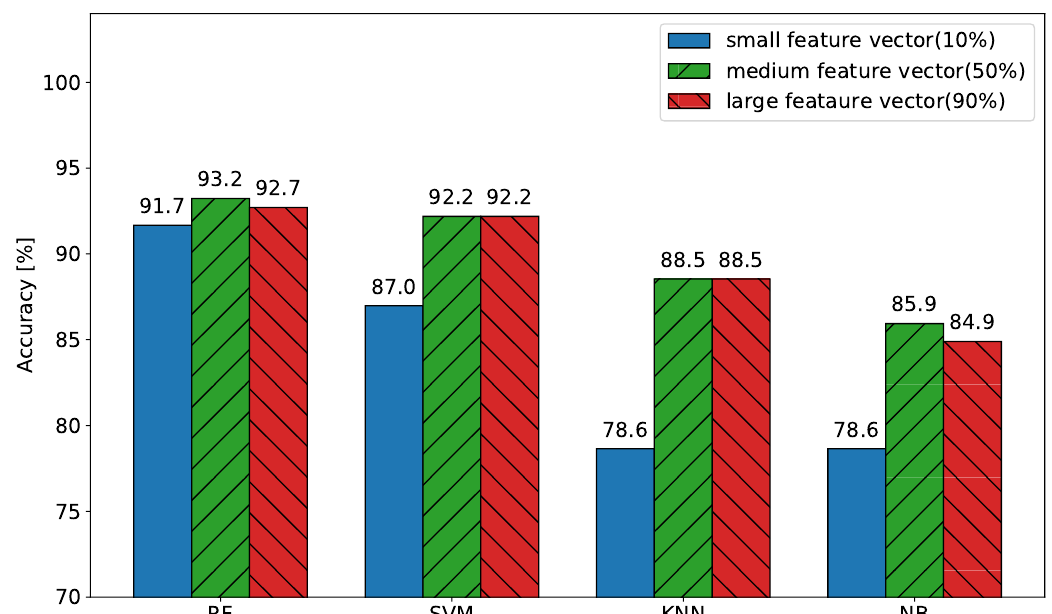
Figure 17. Accuracy scores of all 16 models trained by the ring data set of the ring session. Each model type was trained with three different feature vector sizes and tested against the held-back test data set.